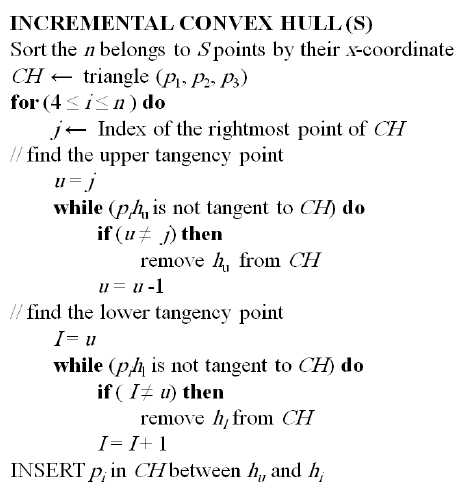
Figure 7. Pseudo code of the convex hull structure.